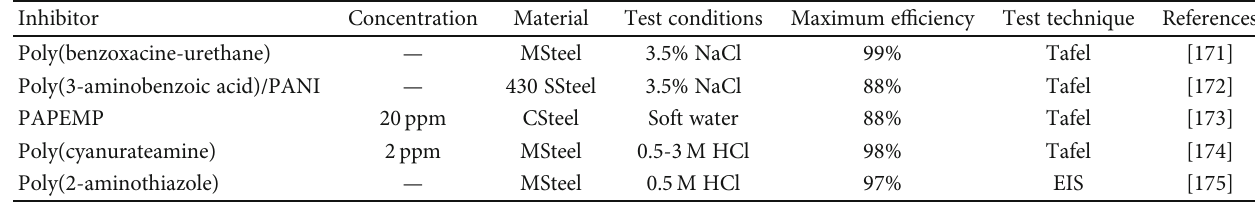
Table 4: Some recently reported polyamine-based corrosion